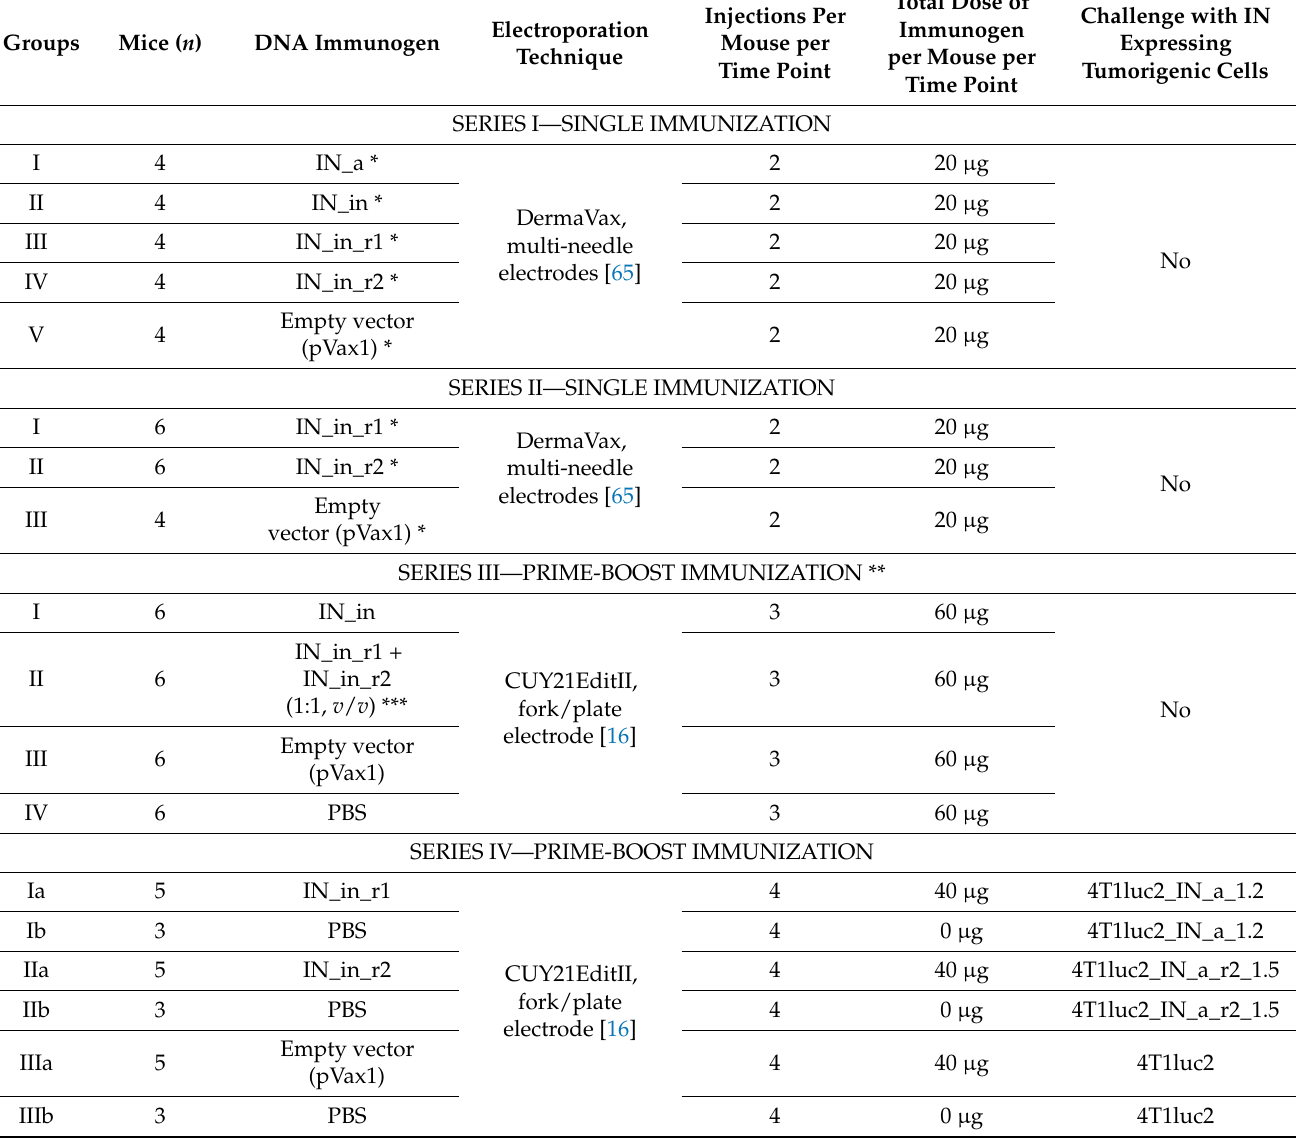
Table 1. Schemes of immunization of mice with IN-encoding plasmids.